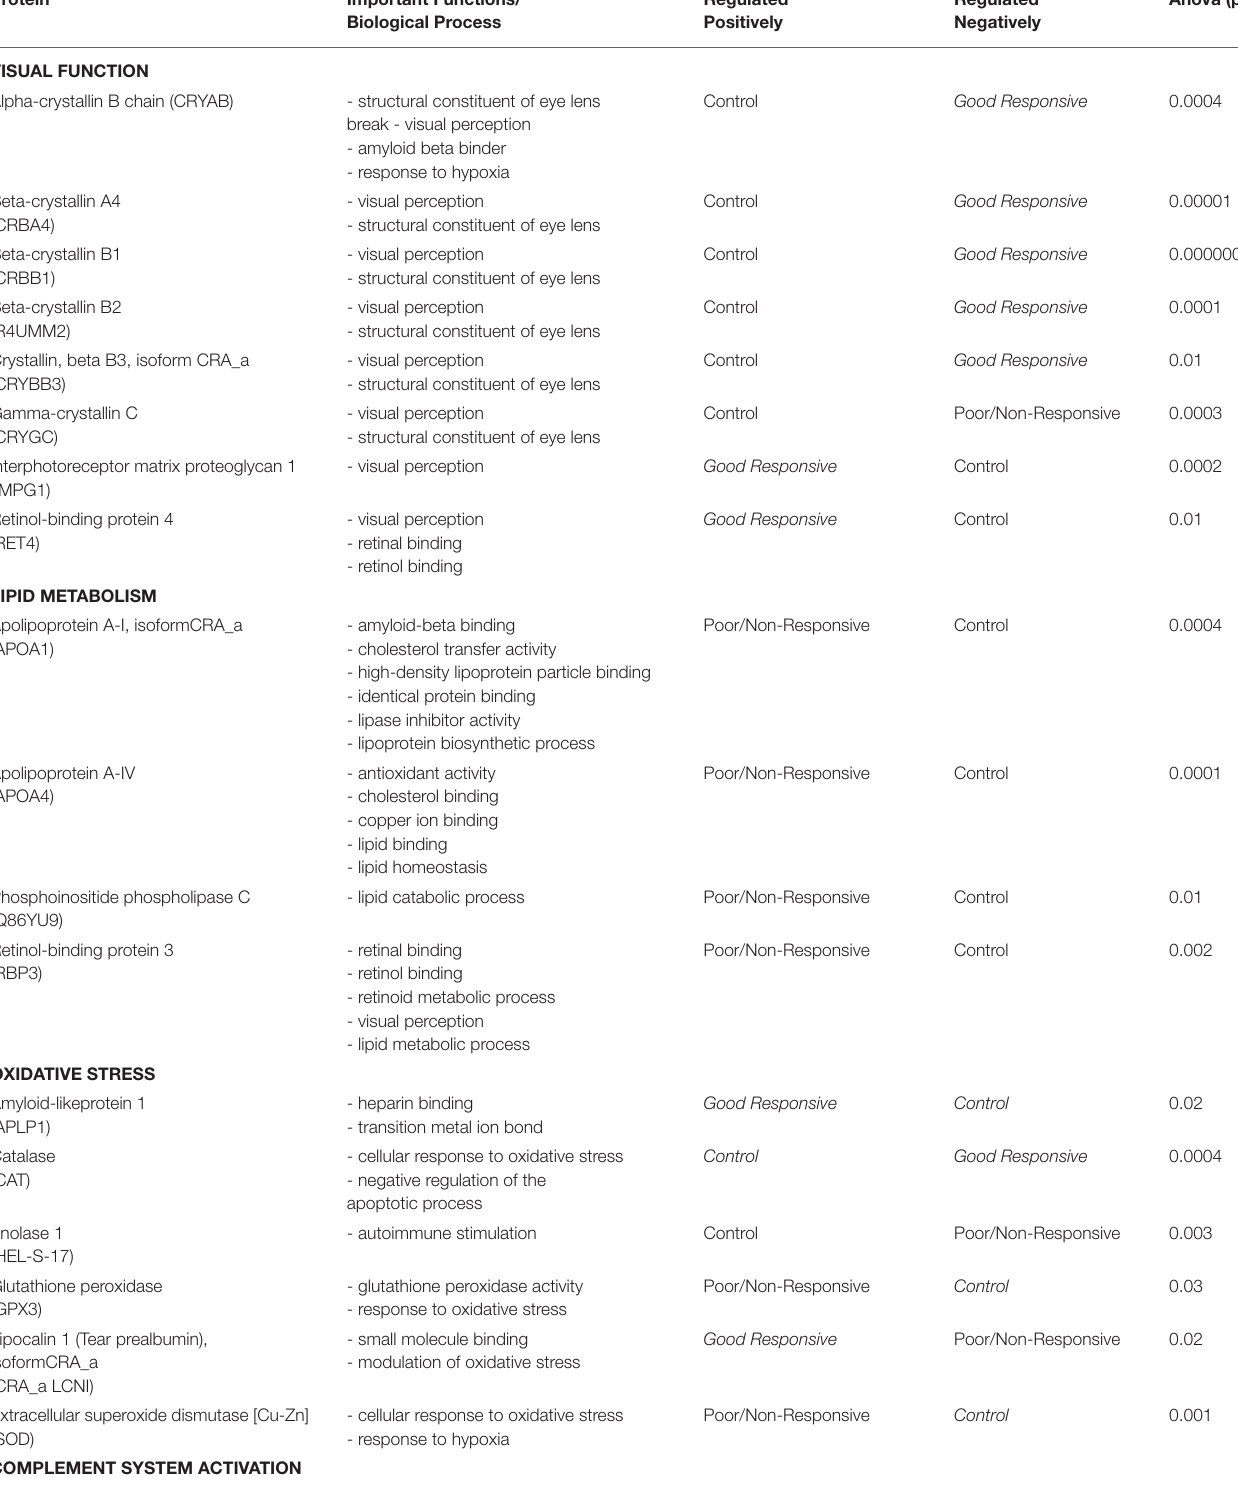
TABLE 2 | Selected discriminant proteins by metabolic function related to the pathophysiology of AMD.